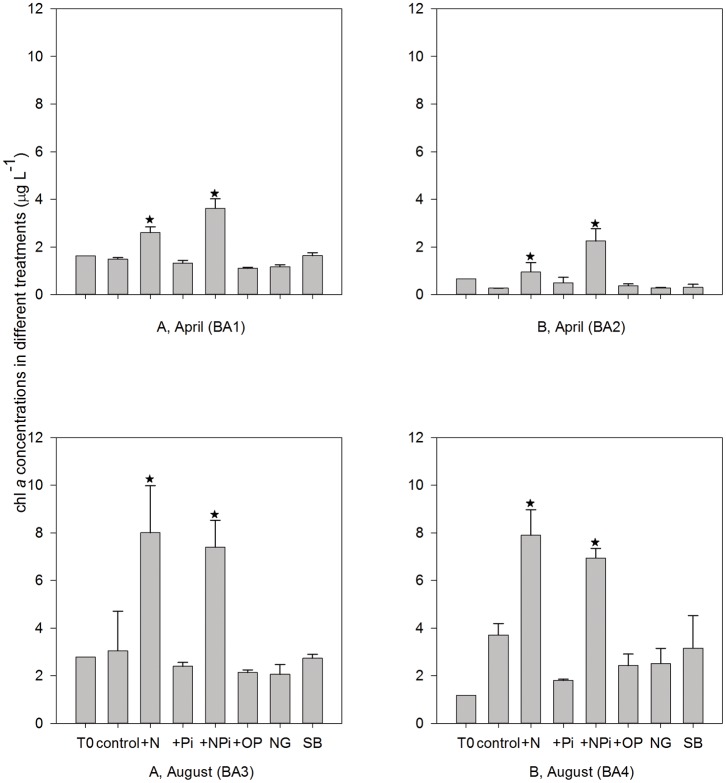
Chl a (µg L−1) concentrations in the different bioassay treatments (mean ± S.E).* indicates significant difference compared with the ‘control’ at the same time point. NG: no grazers, SB: surface+bottom. T0: chl a at start of the bioassay; control: chl a at the end of the bioassay (after 48 hours).